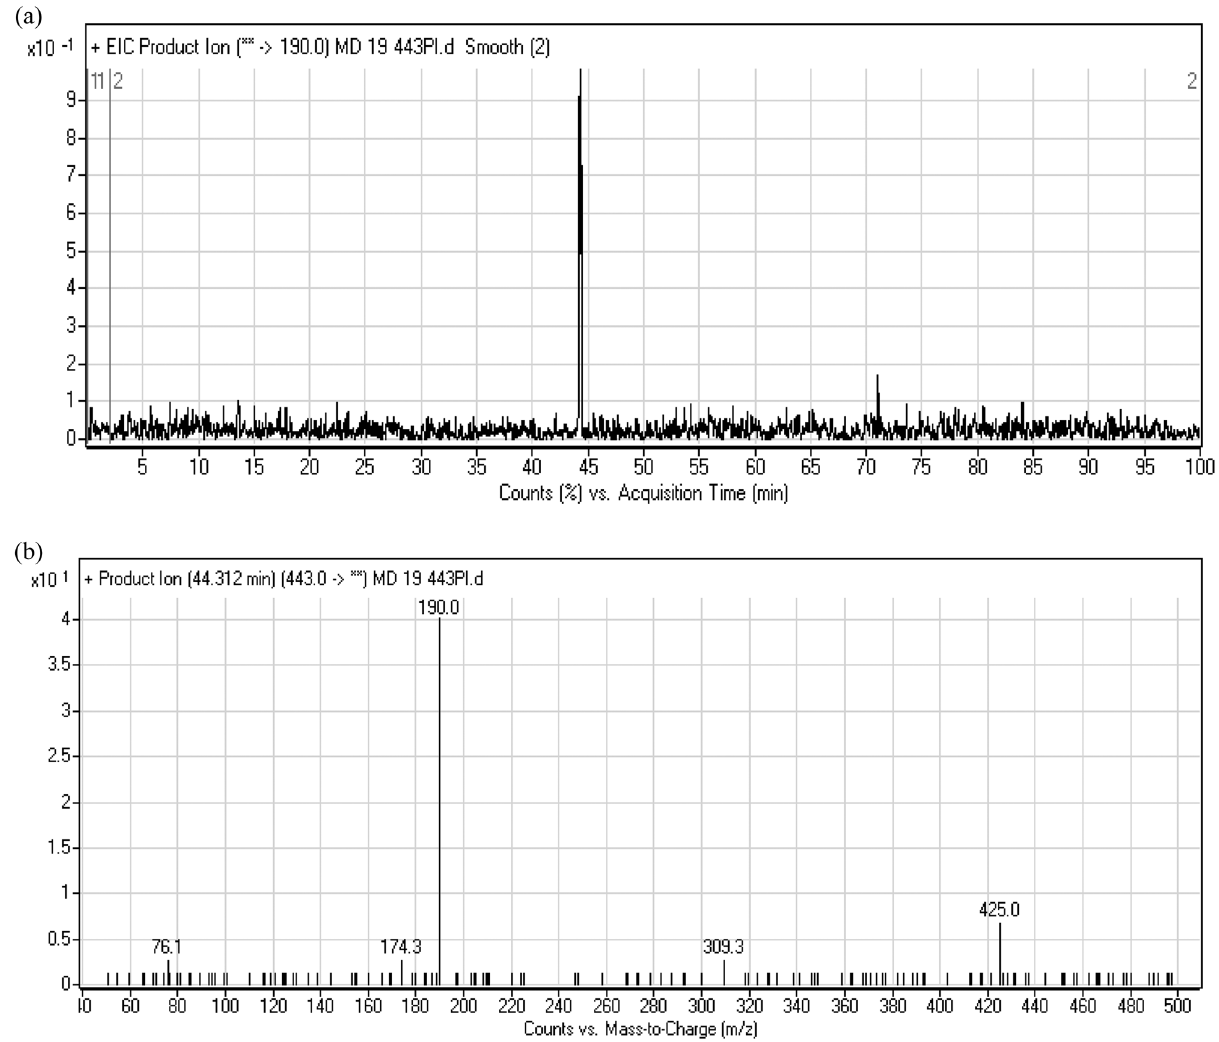
Figure 6: PI chromatogram of M2 showing a chromatographic peak at 44.3 min ( a ) and PI mass spectrum of M2 ( b ) . ( PI fragmentation of M2 at m / z 443 gave two fragment ions at m / z 425 and m / z 190 that showed 16 m / z more units, which revealed the hydroxylation metabolic reaction ) .